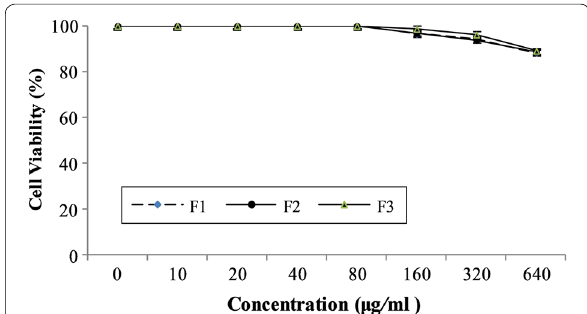
Fig. 2 Cytotoxicity of formulated toothpaste against Vero cells